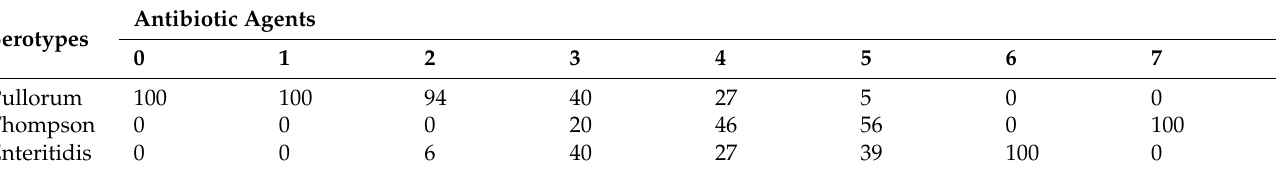
Table 5. Rates of multidrug resistance among three different serotypes